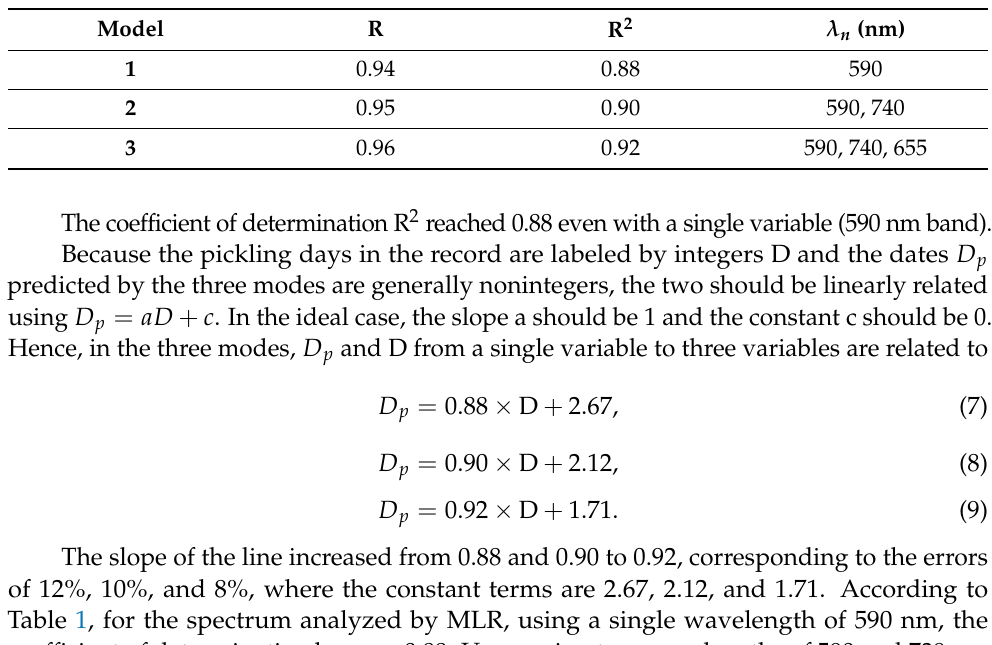
Table 1. Correlation coefficient R, determining coefficient R 2 , and characteristic wavelength λ n of the three modes of the linear regression of the pickling days as a function of the standard normal variate (SNV) transmission